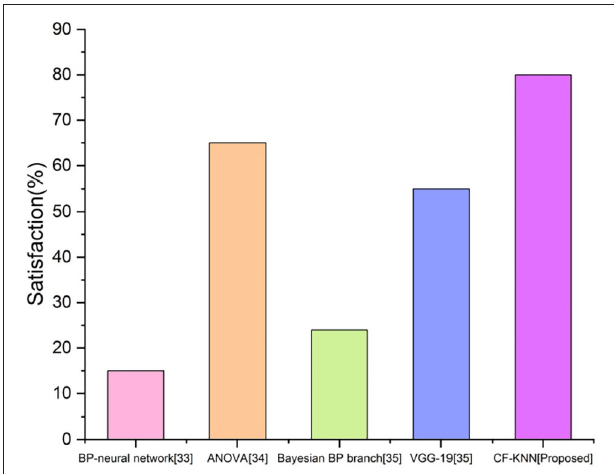
FIGURE 13 | Comparison of satisfaction of proposed and existing techniques.